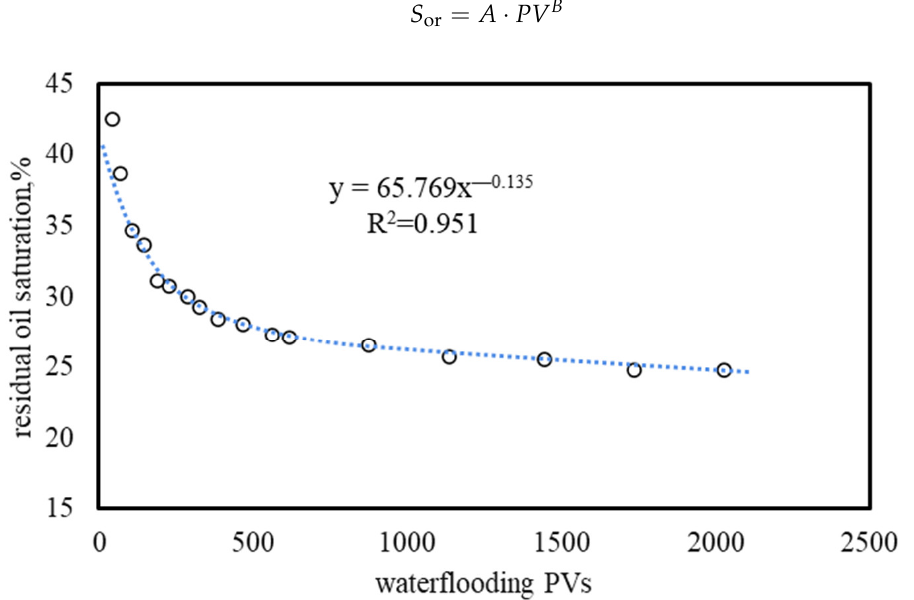
Figure 6. The relationship between the waterflooding PVs and the residual oil saturation.